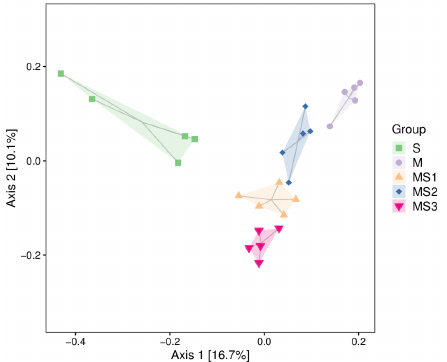
Figure 4. Unweighted UniFrac PCoA plot of the five silage treatments. S: monoculture of soybean; M: monoculture of maize; MS1, MS2, and MS3 mean different row ratio of maize and soybean in- tercropping (1:1, 1:3 and 1:5).